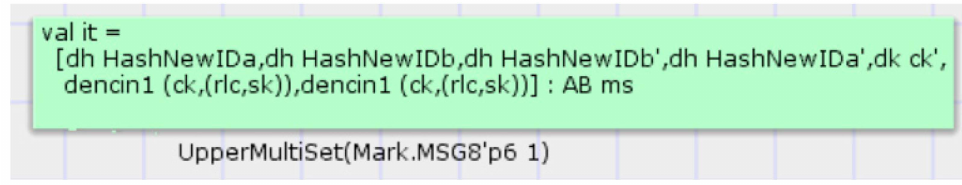
Figure 16. Information search in attacker’s place.